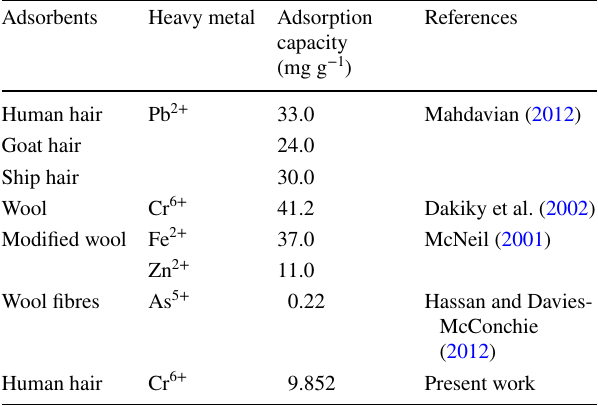
Table 4 Comparison of heavy metal uptake by various keratinous substances